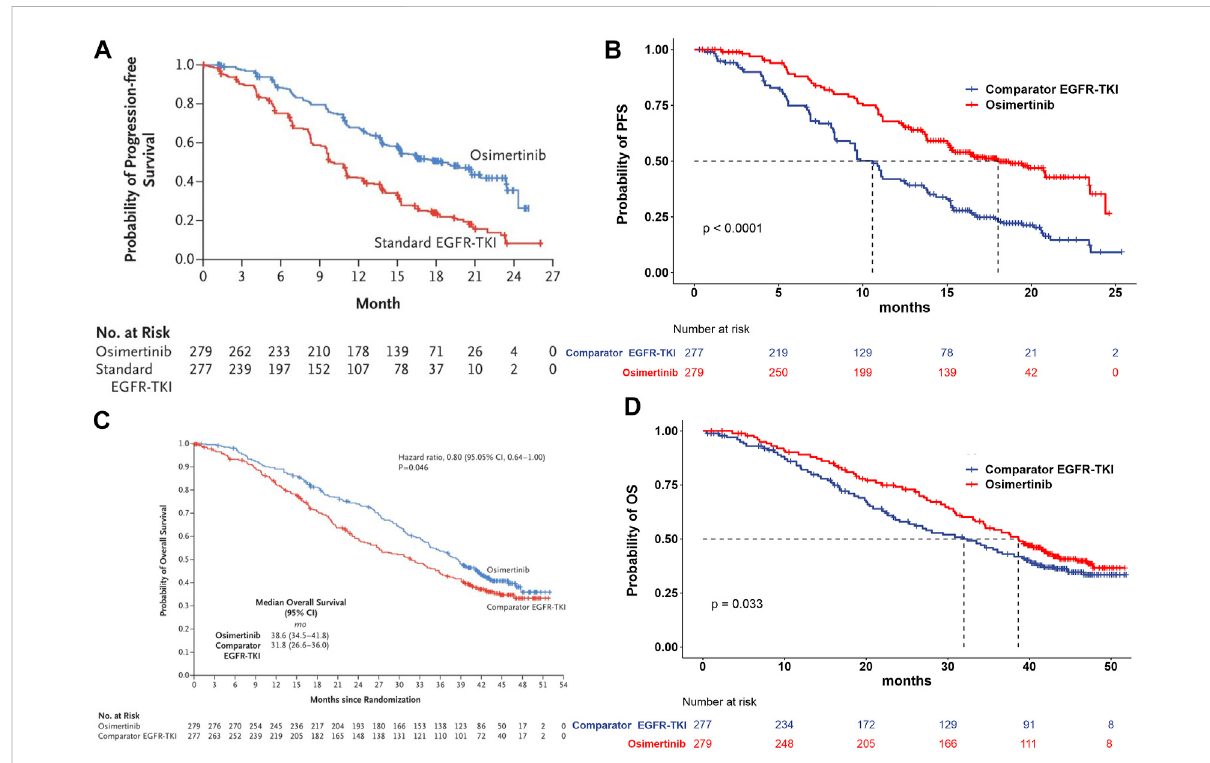
FIGURE 2 Model estimated PFS and OS were plotted together with the original Kaplan – Meier PFS and OS curves from the FLAURA trial, respectively. (A) Kaplan – Meier curve of the progression-free survival from the FLAURA trial. (B) Simulation of the progression-free survival curve for osimertinib and thecomparatorEGFR-TKI. (C) Kaplan – MeiercurveofoverallsurvivalfromtheFLAURAtrial. (D) Simulationoftheoverallsurvivalcurveforosimertinib and the comparator EGFR-TKI. Abbreviations: PFS, progression-free survival; OS, overall survival; EGFR-TKI, epidermal growth factor receptor – tyrosine kinase